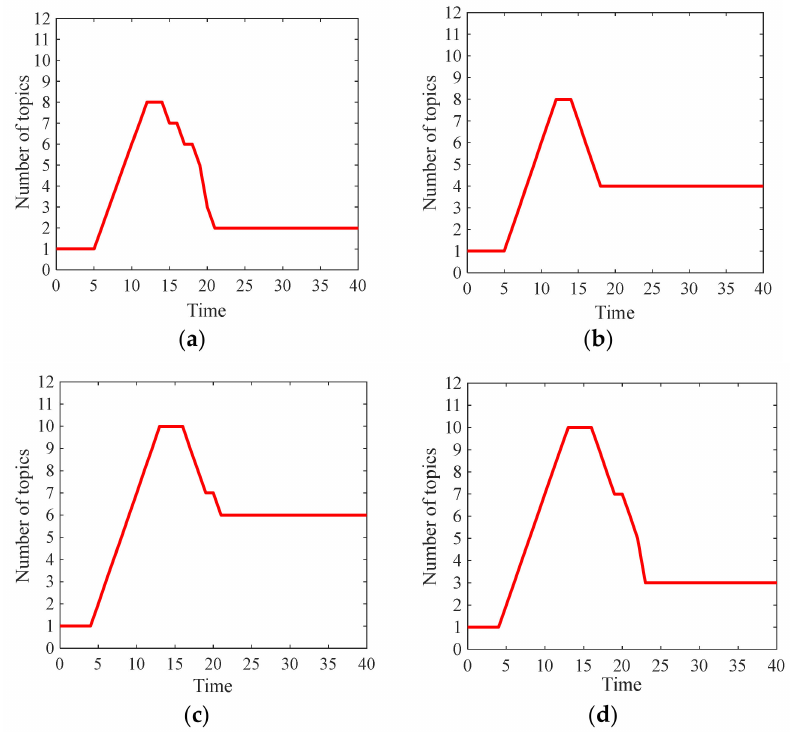
Figure 24. The change of the number of topics under different distributions of the amount of information. ( a ) σ i ~N (0.1, 0.3). ( b ) σ i ~N (0.5, 0.3). ( c ) σ i ~N (0.9, 0.3). ( d ) σ i ~U [0,